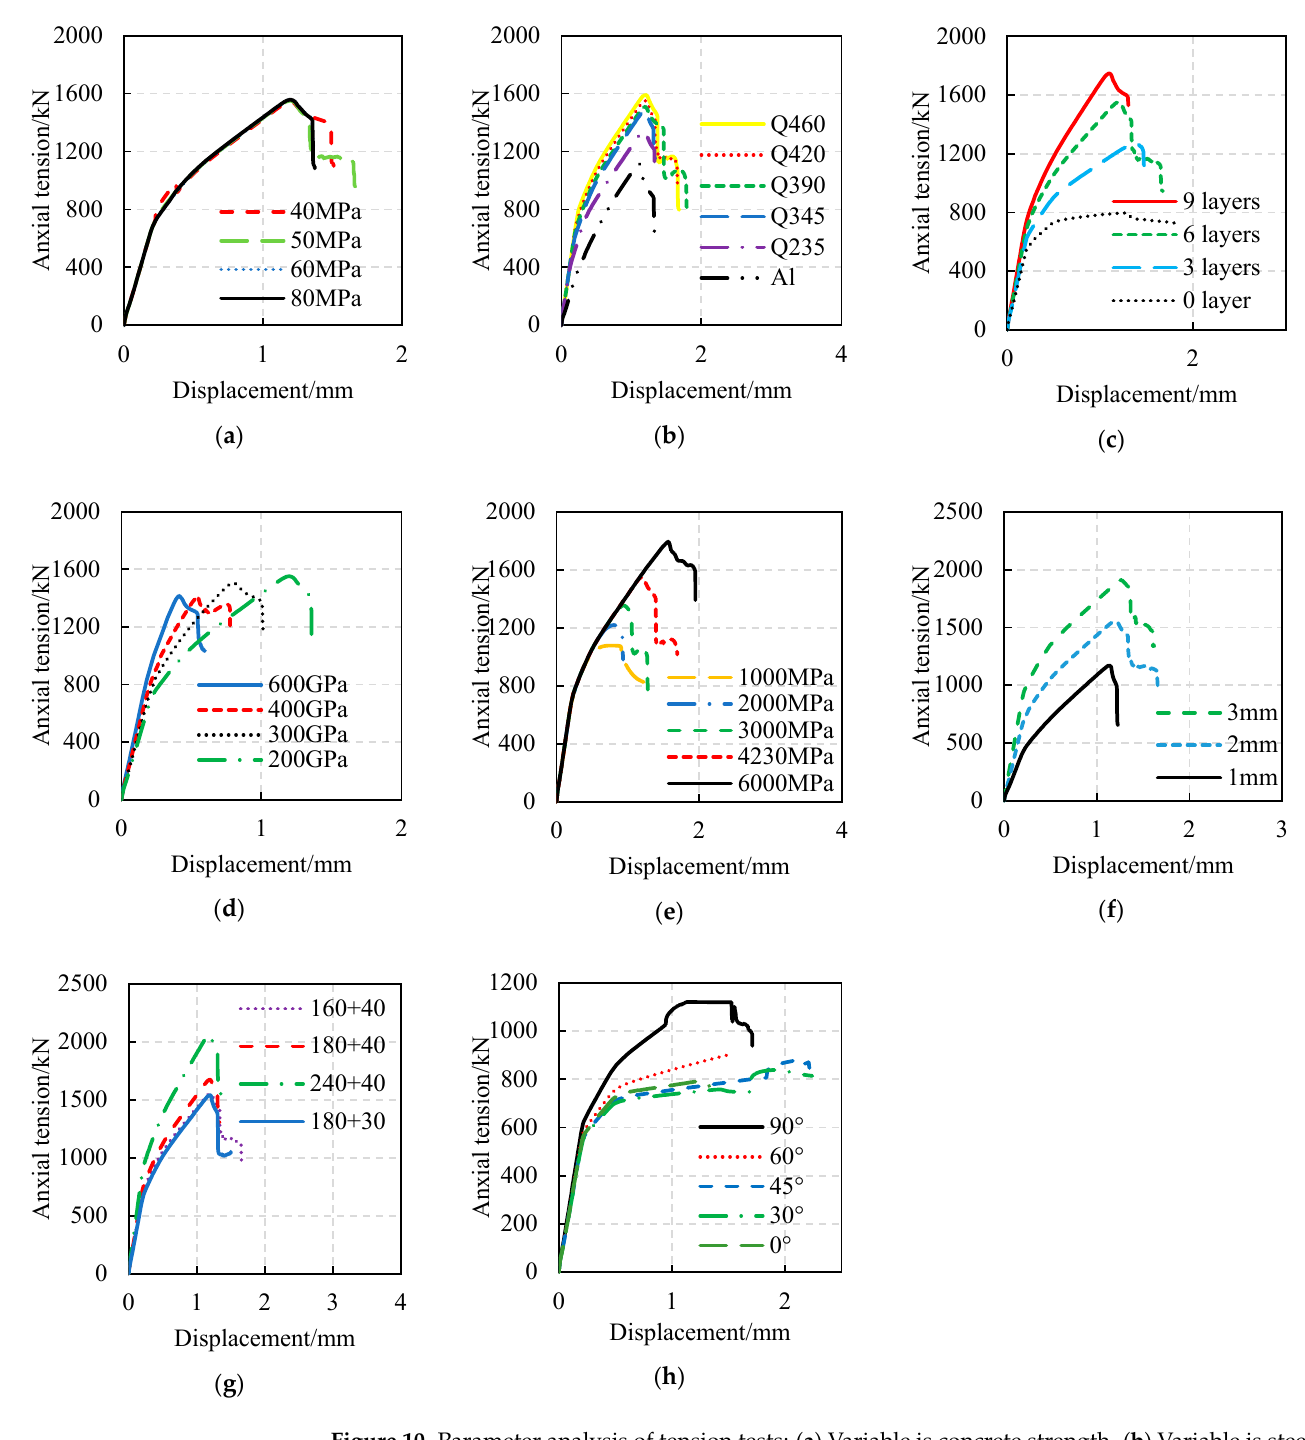
Figure 10. Parameter analysis of tension tests: ( a ) Variable is concrete strength. ( b ) Variable is steel grade. ( c ) Variable is the number of 90° CFRP layers. ( d ) Variable is the elastic modulus of CFRP. ( e ) Variable is the ultimate tensile strength of CFRP. ( f ) Variable is the thickness of the steel tubes. ( g ) Variable is the section size of the FWP. ( h ) Variable is the angle of the CFRP.